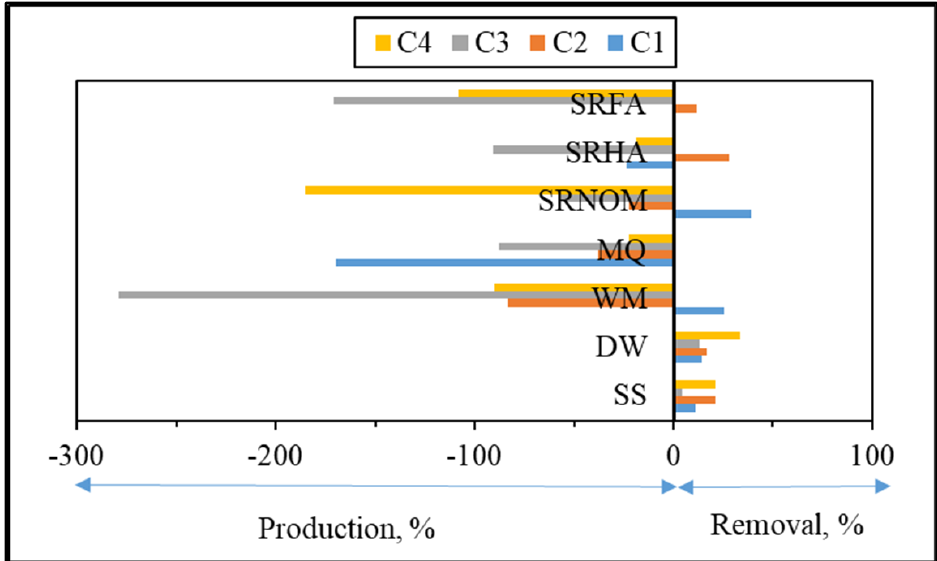
Figure 10. Changes in normalized Fmax values of PARAFAC components upon the SPCI of E. coli in the absence/presence of NOM using LF (t irr = 60 min).